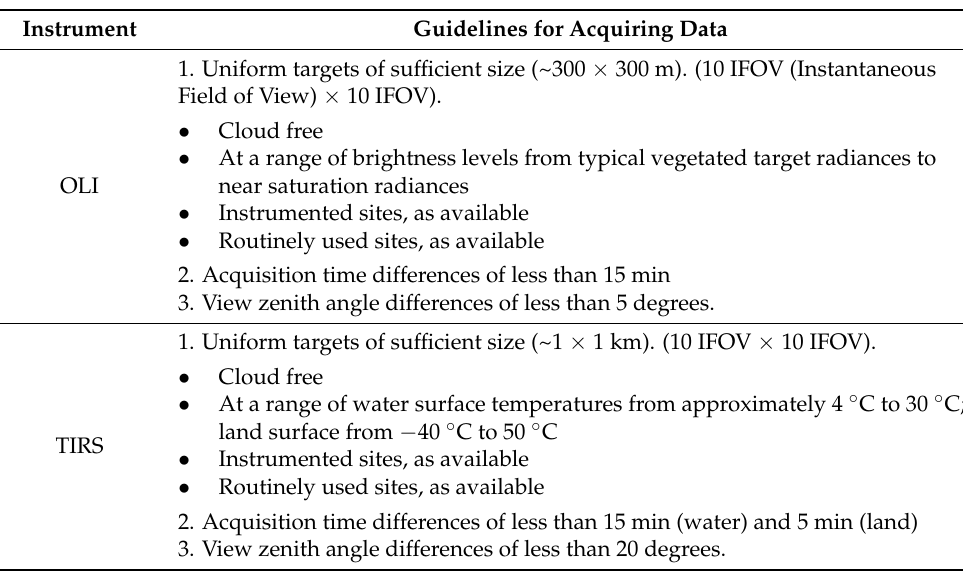
Table 1. Guidelines for Acquiring Data.